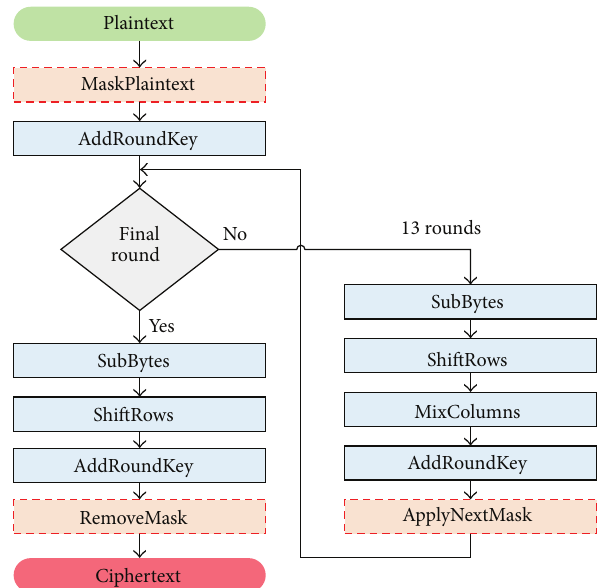
Figure 1: AES-256 with the Rotating S-Box Masking (RSM) pro- tection. RSM is a Low Entropy Masking Scheme. The dashed boxes represent the operations added by RSM to